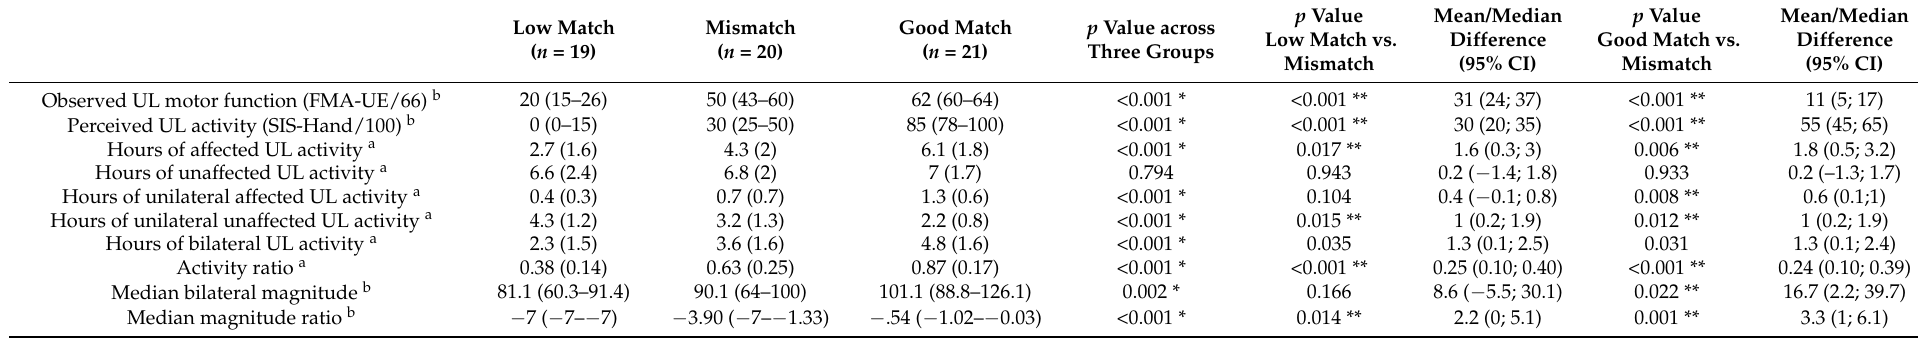
Table A1. Upper limb functioning and accelerometry outcomes over 24 h across the three groups presented as mean (SD) or median (Q1–Q3) based on the old cut-off values.